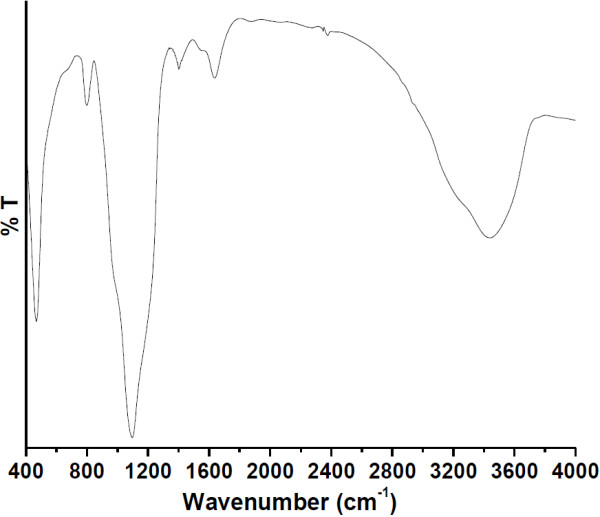
FTIR spectrum of the prepared luminescent mesoporous Tb(OH)3@SiO2core-shell nanosphere.